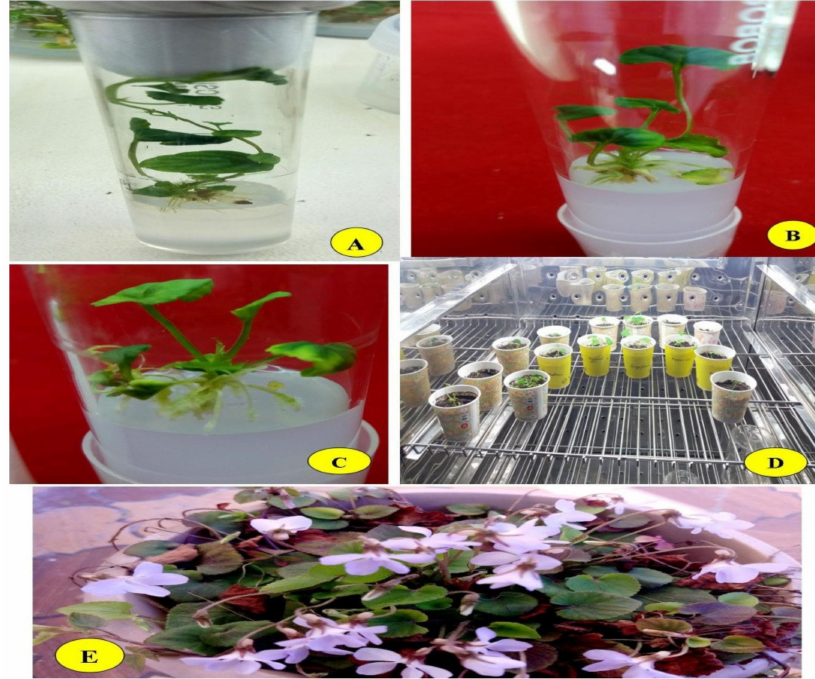
Figure 2. Regenerated V. canescens plants on MS medium ( A – C ). Plantlet acclimatization in the growth chamber ( D ). Representative 1-year-old established plantlet at the flowering stage ( E